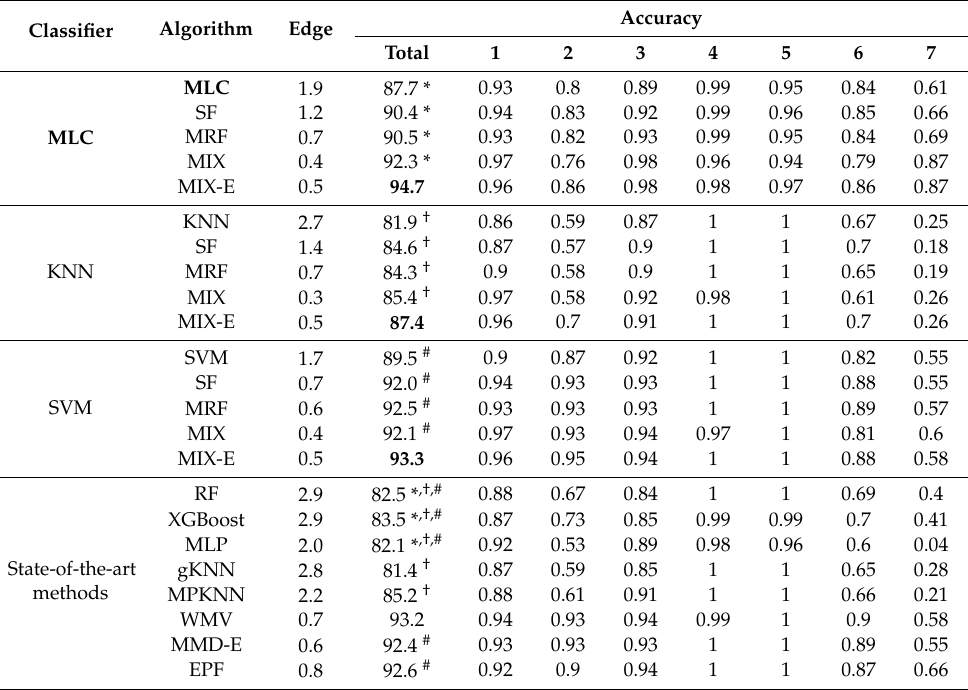
Table 4. Overall accuracy (%), F1-score per class, and edge index of classification results for the Landsat